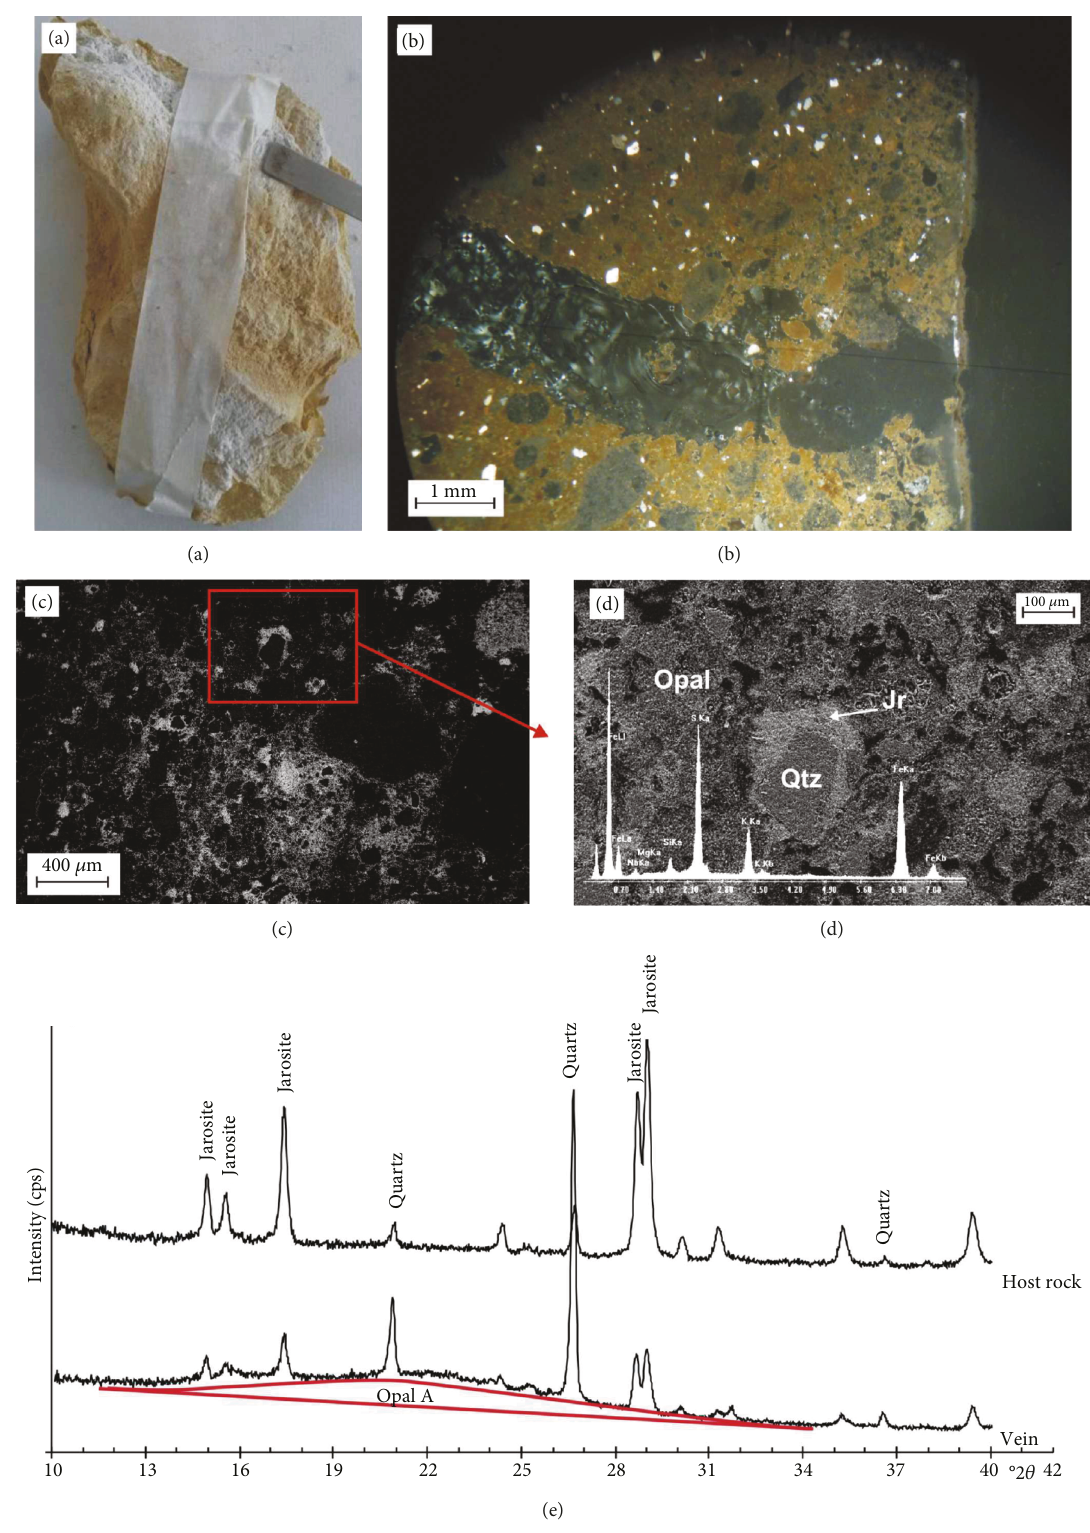
Figure 8: (a) Picture of representative sample (host rock white and brown vein); (b) OM observations; (d) SEM image and EDX spectra goethite. Jr: jarosite, Kfs: k-feldspar. (e) XRD di ff raction pro fi les of the host rock and